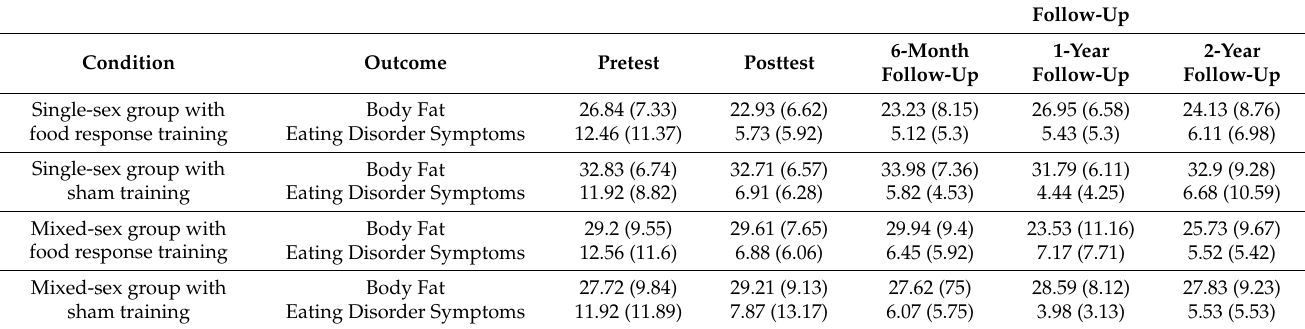
Table 1. Descriptive Summary for Study Variables by